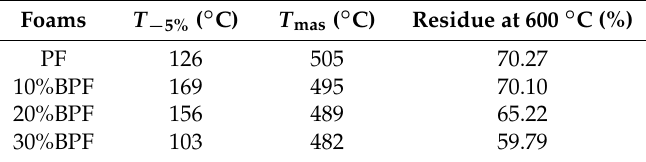
Figure 4. Thermogravimetric (TG) and derivative thermogravimetric (DTG) curves of PF and BPFs. Table 5. Degradation data of PF and BPFs by TG